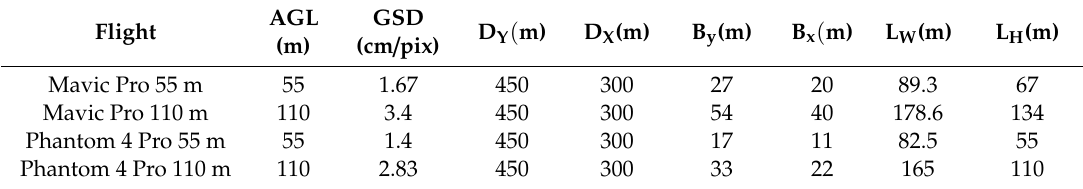
Table 1. Flight plan parameters. AGL: above ground level and GSD: ground sample distance. AGL GSD D Y ( m) D X (m) B y (m) B x ( m) L W (m) L H (m) Flight (m) (cm / pix) Mavic Pro 55 m 55 1.67 450 300 27 20 89.3 67 Mavic Pro 110 m 110 450